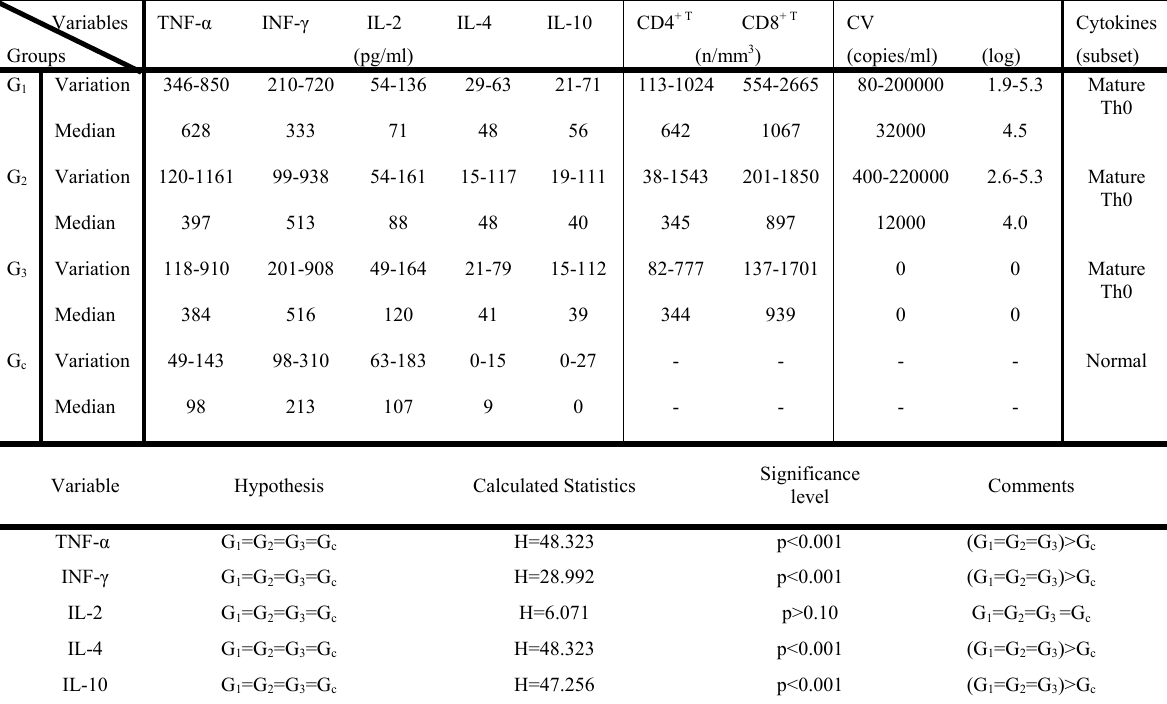
G 1 =11 patients with HIV-1 without treatment; G 2 =40 patients with HIV-1 on retroviral treatment, 33 with two NRTI and seven on HAART, with VL>80 copies/ml; G 3 =28 patients with HIV-1 on antiretroviral treatment, 23 on HAART, and five with two NRTI and undetectable VL for at least the past 6 months; G c =20 normal blood donors (control